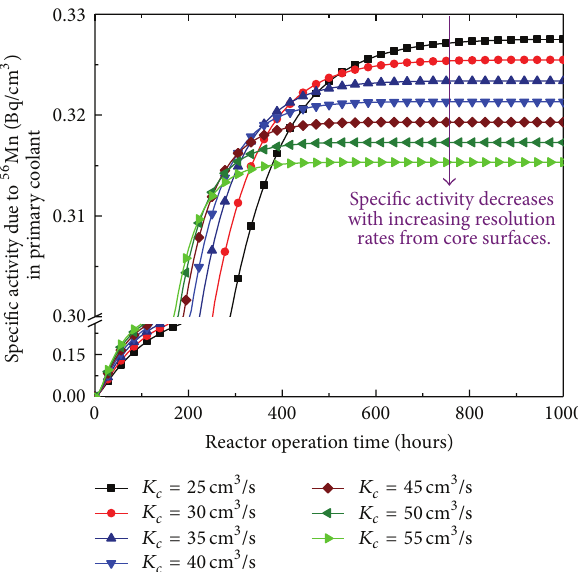
Figure 3: Specific activity of 56 Mn as a function of reactor operation time in primary coolant of PWR with different values of 𝐾 𝑐 .